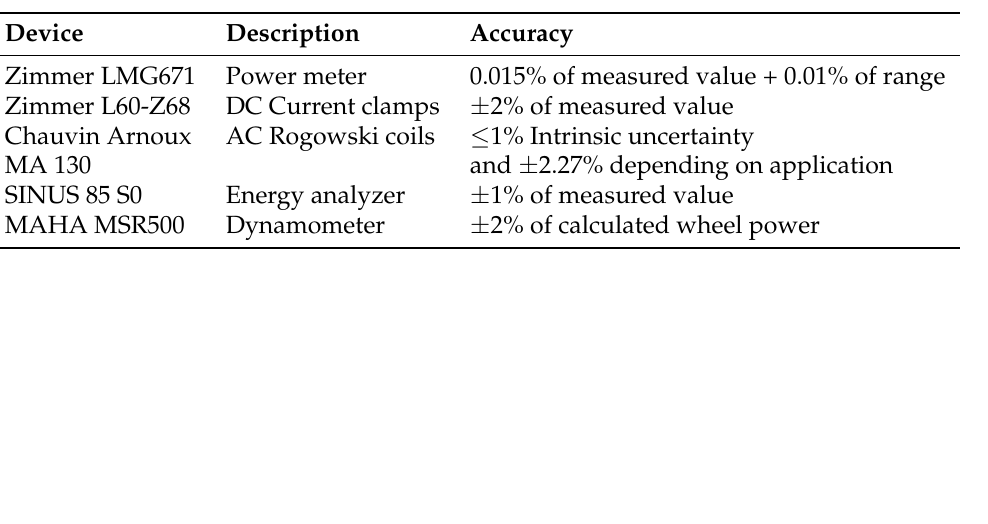
Table 3. Accuracy of the individual measuring